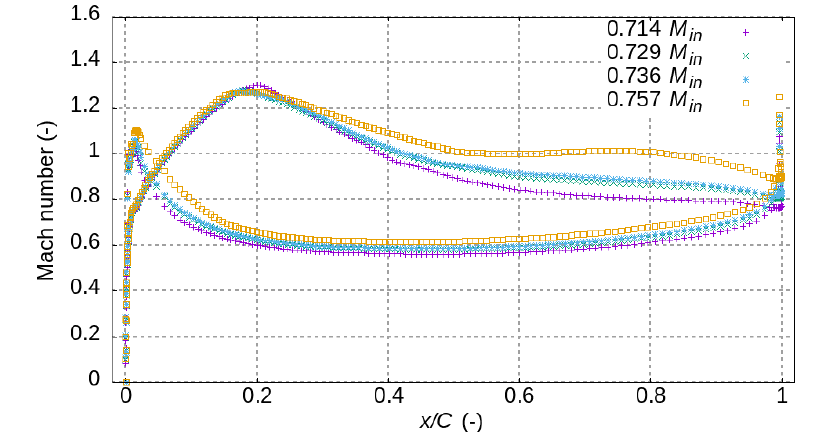
Figure 11. Midspan time-averaged isentropic Mach number profiles for varying M in at buffeting operating